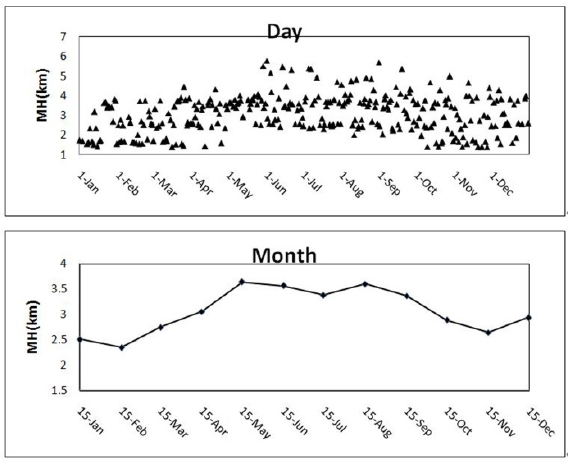
Figure 11. Daily and monthly variation in the MH calculated from the MODIS profile data from the Gaoya station in